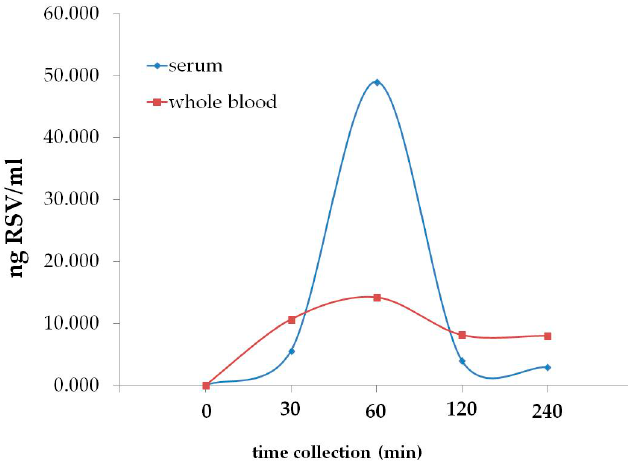
Figure 2. Bioavailability of RSV in acute. RSV levels evaluated in serum and whole blood samples before (time 0) and after (30, 60, 120, and 240 min) the administration of 2 AR capsules containing 300 mg Taurisolo ® . In both serum and whole blood, the maximum levels of RSV (49.0 ± 0.55 and 14.2 ± 0.40 ng/mL, respectively) were detected 60 min after the nutraceutical administration.